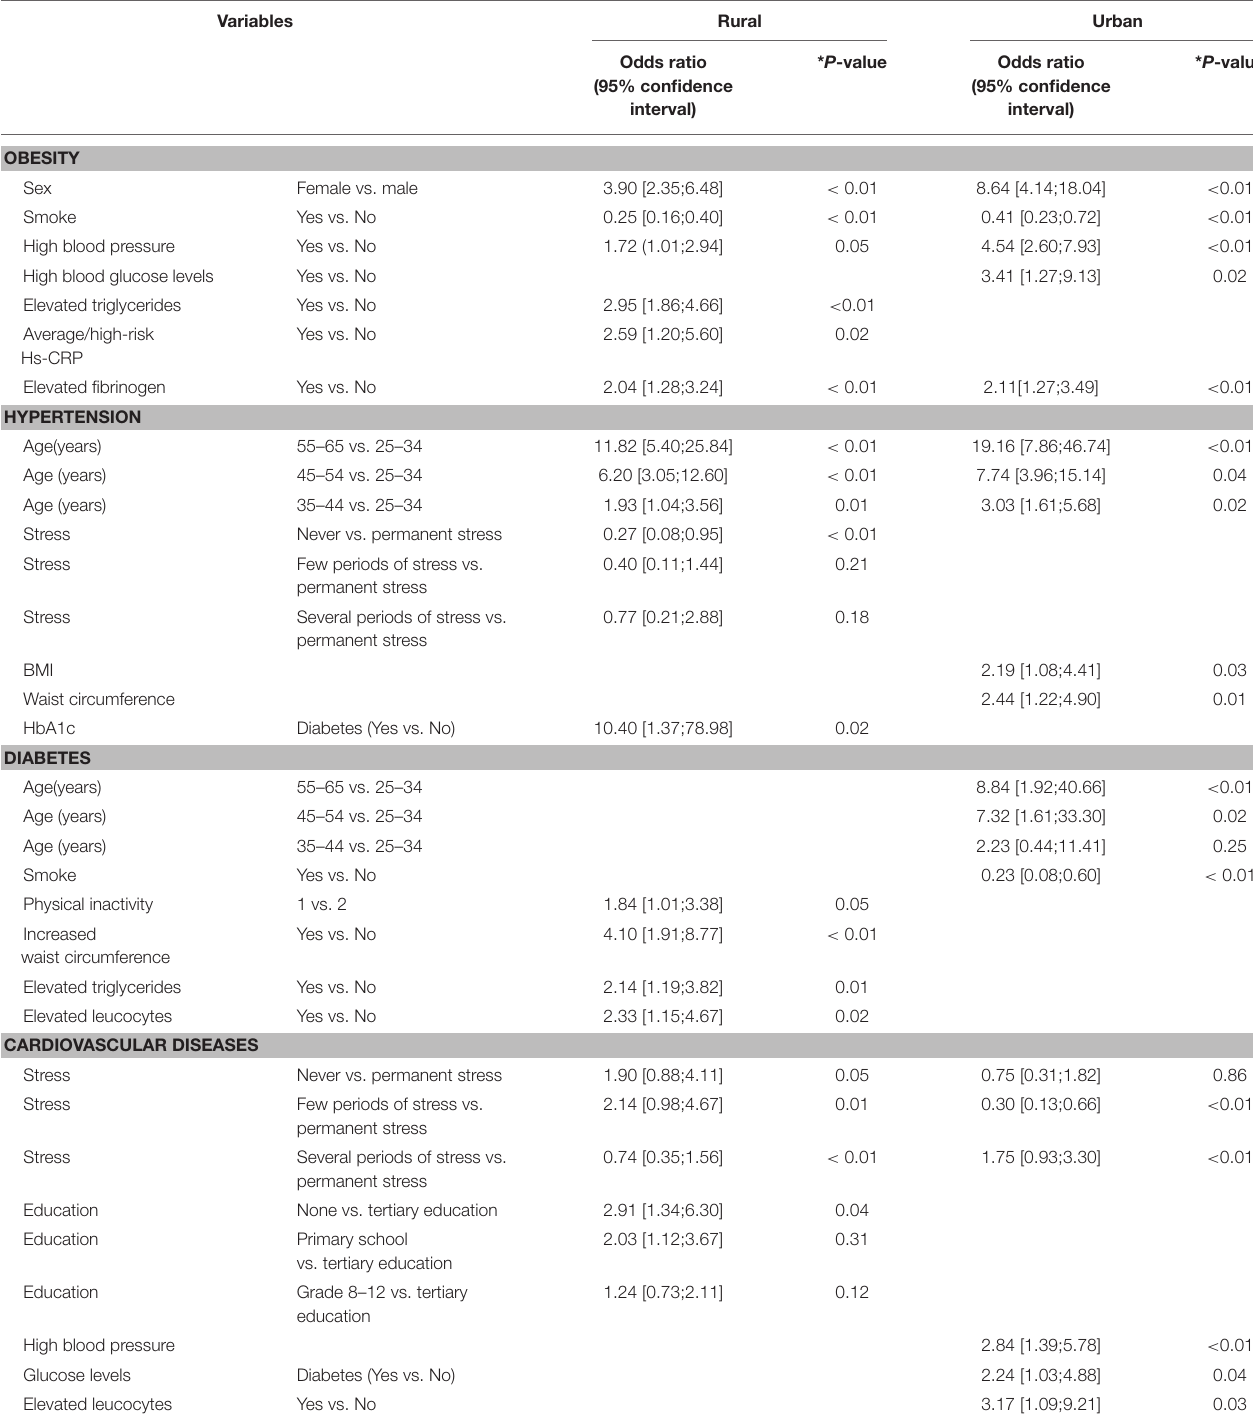
TABLE 5 | Significant socio-behavioral-metabolic risk factors, inflammatory biomarkers associated with the presence of obesity, cardiovascular disease, hypertension, and diabetes mellitus in a rural and urban sample. Variables